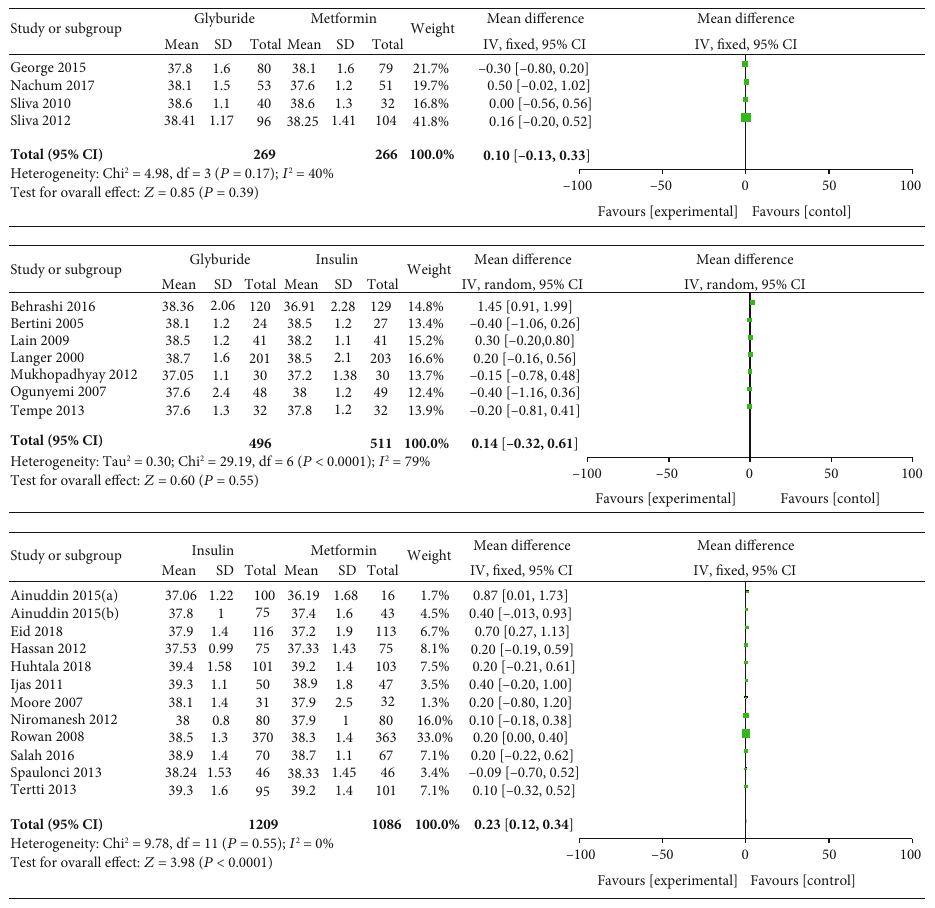
Figure 9: Gestational age at delivery.